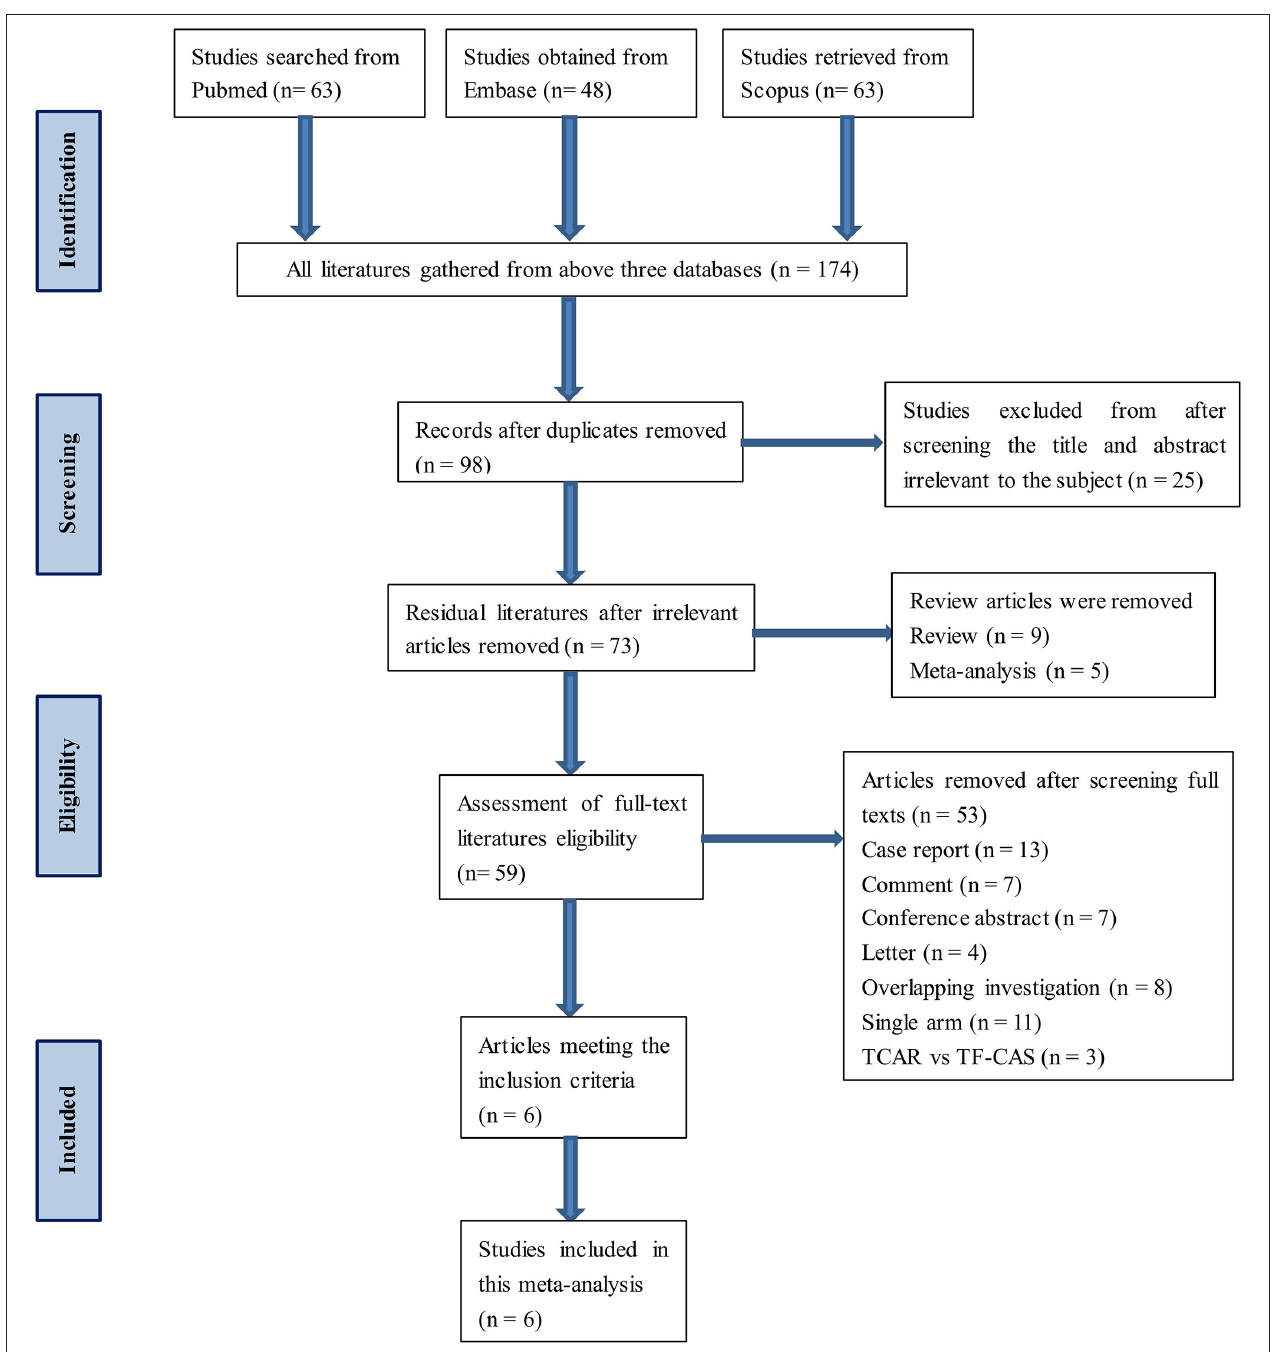
FIGURE 1 | Flow diagram of search results and article screening.